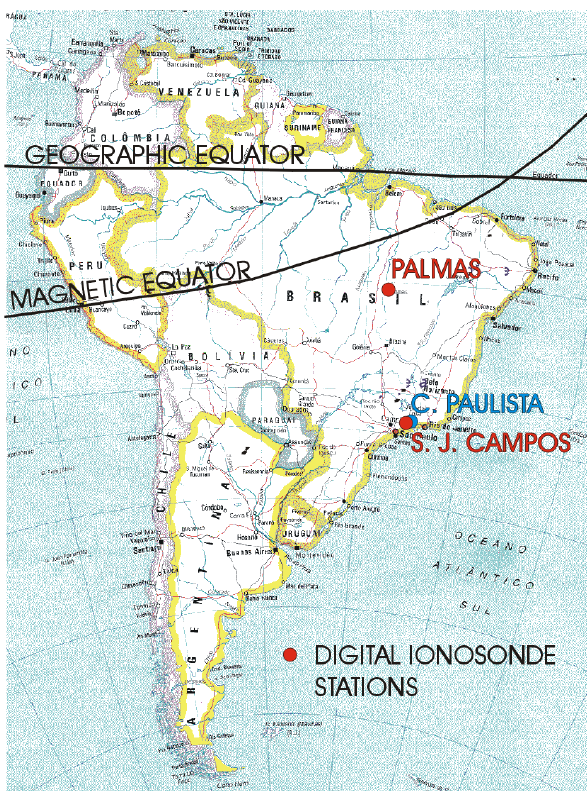
Fig. 1. A map showing the locations of the ionospheric sounding stations Palmas and Sao Jose dos Campos. Also, the location of Cachoeira Paulista indicated in the paper is